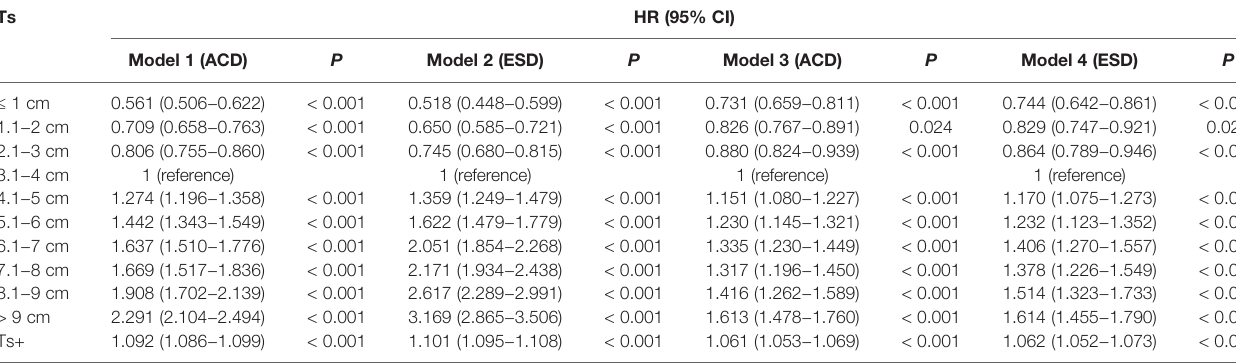
TABLE 2 | Univariate and multivariate Cox regression analyses of ACD and CSD according to Ts in patients with endometrial cancer. Ts HR (95%